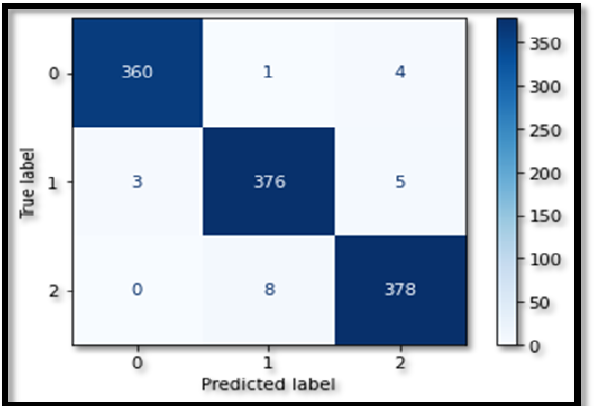
Fig. 9. ROC curve on the grape dataset The confusion matrix containing the Corn test data for which 0: healthy,1: Cercospora leaf spot Gray leaf spot, 2: Common rust, 3: Northern Leaf Blight is presented in Fig. 10. Fig. 11 shows that the realm under the ROC curve for our classification is 94%.